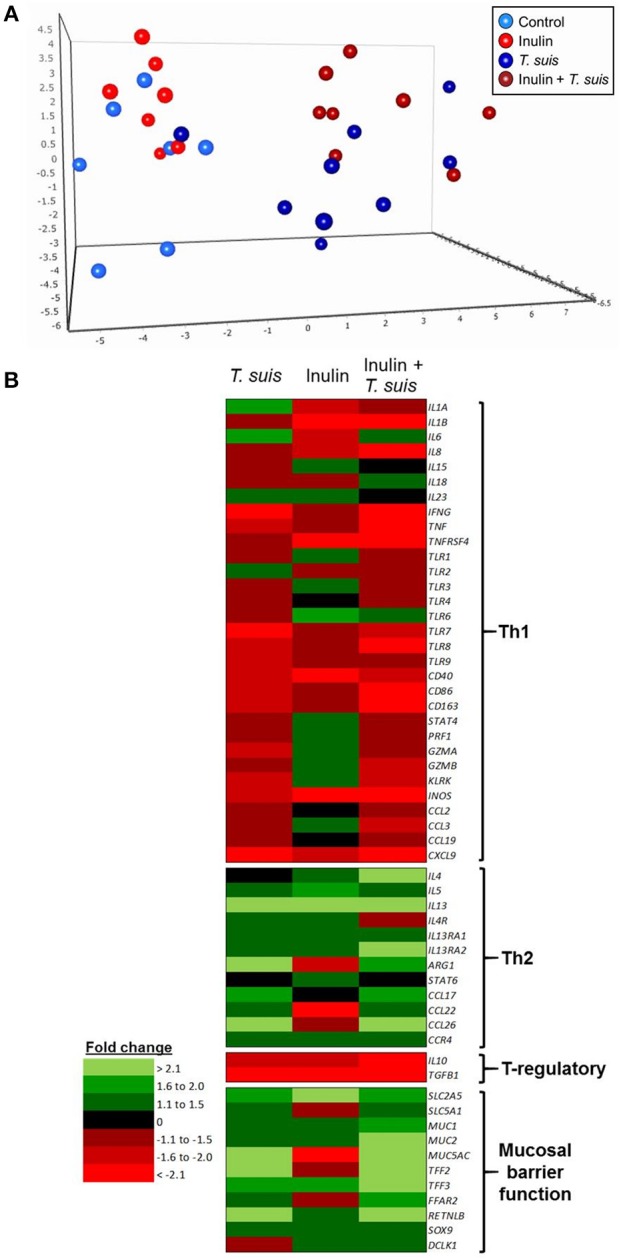
Diet and helminth infection greatly influences intestinal gene expression profiles. QPCR gene expression analysis of proximal colon tissue obtained at day 28 post-infection: (A) Principal component analysis of the relative expression of all immune genes (excluding housekeeping genes) from the four treatment groups: Control (n = 7); Inulin (n = 7); T. suis (n = 9); Inulin + T. suis (n = 8). (B) Fold change heat map of all immune genes analyzed. All fold change data are relative to the uninfected, control-fed group.